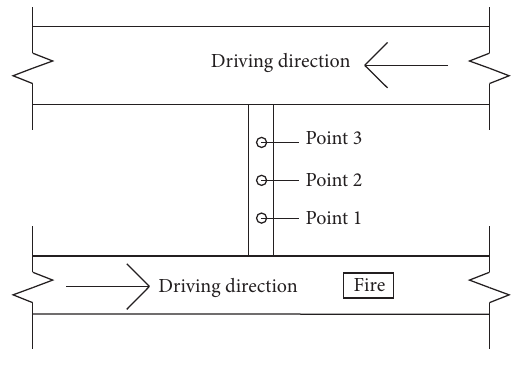
Figure 9: Arrangement of measuring points.